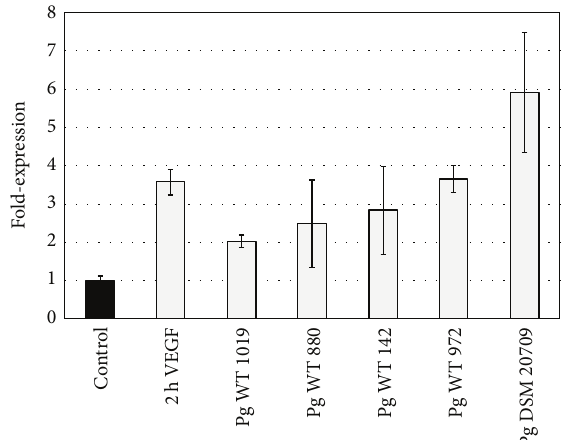
Figure4:Expressionof rcan1 inendothelial(HUVEC)cells.Expres- sion of rcan1 following 2 h incubation with medium (negative con- trol), VEGF (positive control), and P. gingivalis strains DSM 20709, WT 149, WT 880, WT 972, and WT 1019. Error bars indicate ± SD.